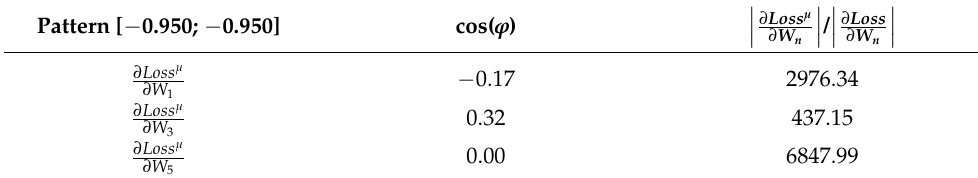
Table 3. Worst learnt pattern’s ∂ Loss for the FC layers. Both weight matrices, the average and pattern ∂ W n µ , are reshaped to a single row array of values before doing the scalar multiplication; otherwise, a bound of results would be generated for each one of the output values of the current layer. The rest of the Layers, the Processing ones, are not displayed, as they would not be modified during the learning process.